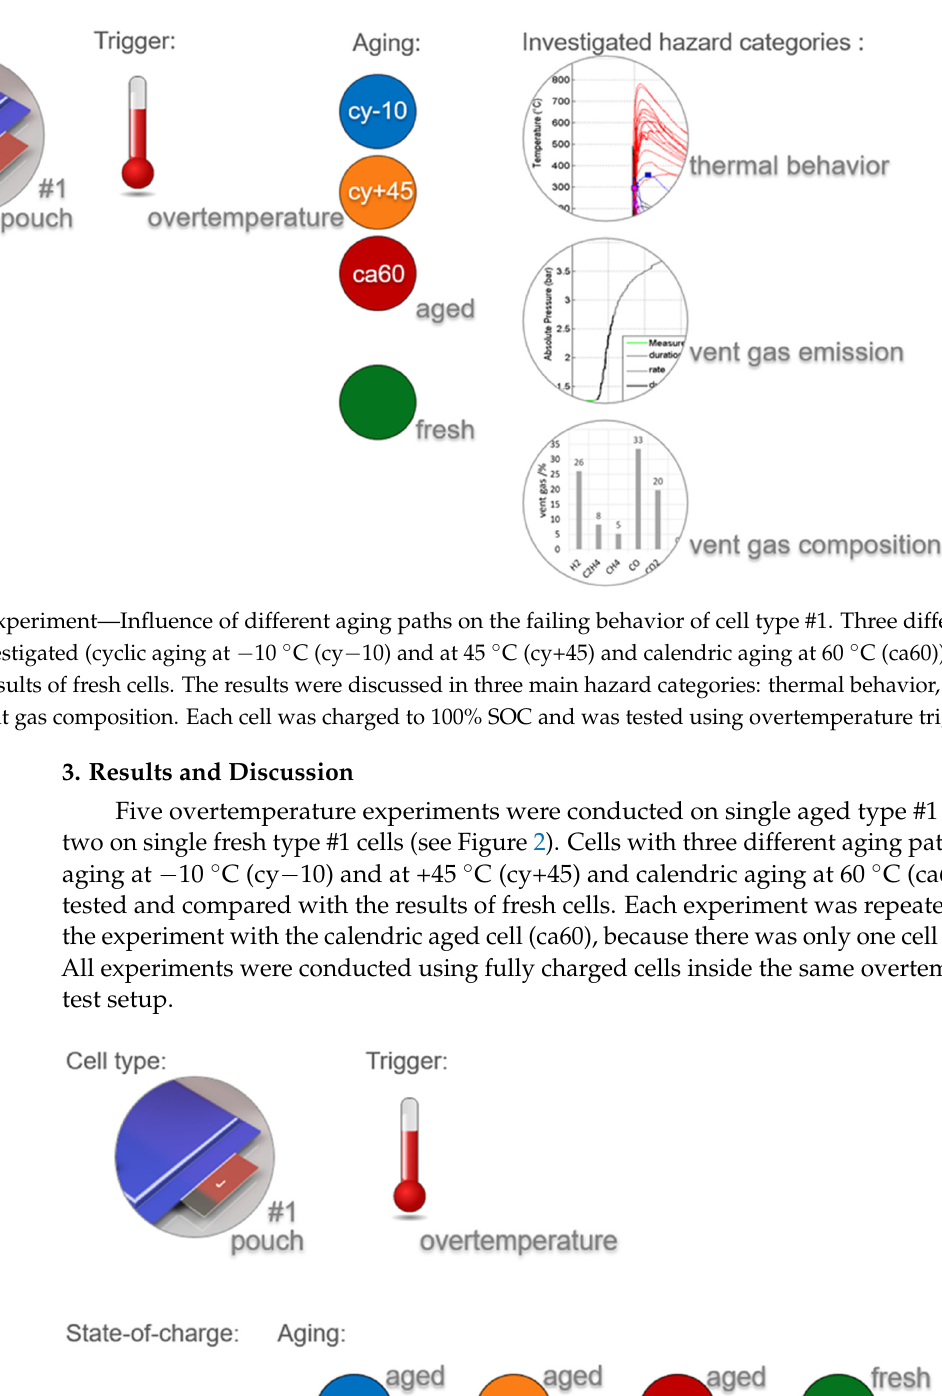
Figure 3. Comparison of safety relevant thermal parameters in overtemperature triggered TR of fresh (green) and aged (cy − 10: blue, cy+45: orange, ca60: red) #1 cells. ( a ) The measured capacity of the cells immediately before the TR